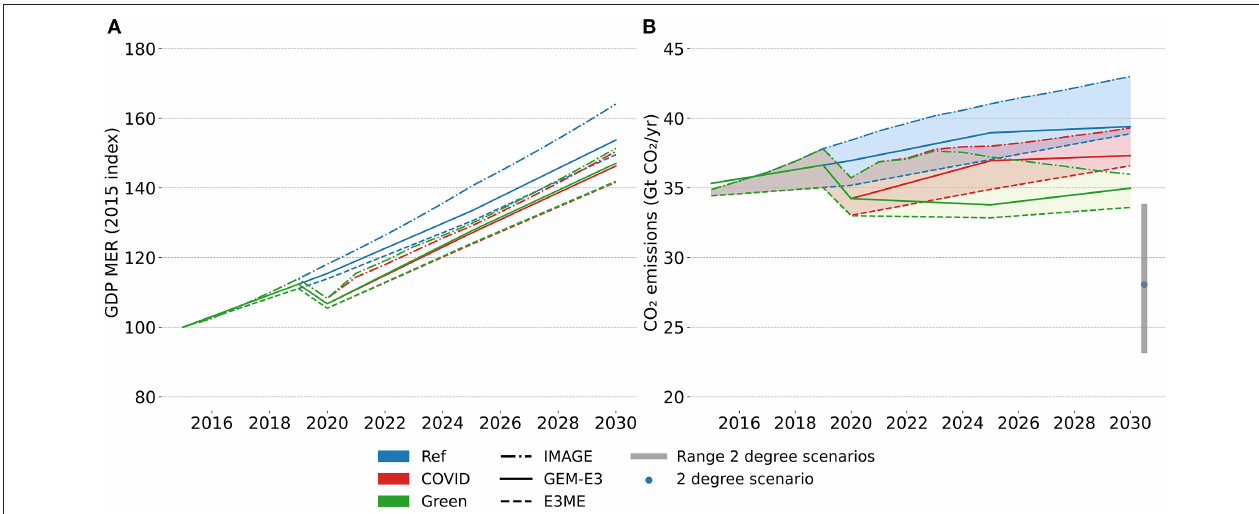
FIGURE 1 | Global GDP and CO 2 emission projections. (A) Global GDP (expressed in MER US$) between 2015 and 2030 (normalized to 2015 levels), for all scenarios, as projected by the three global models. (B) Global CO 2 emission projections from energy and industrial processes between 2015 and 2030, for all scenarios. The 2 ◦ C scenario range shows the global CO 2 emissions from energy and industrial processes consistent with a least cost-pathway toward limiting global average temperature increase below 2 ◦ C by 2100 with about 66% probability ( van Soest et al., 2021). All results in the paper have not been adjusted with a harmonization process–we show the original data. We find that harmonization toward 2019 global CO 2 emissions and GDP would reduce the range of results, as presented in Supplementary Figure 1